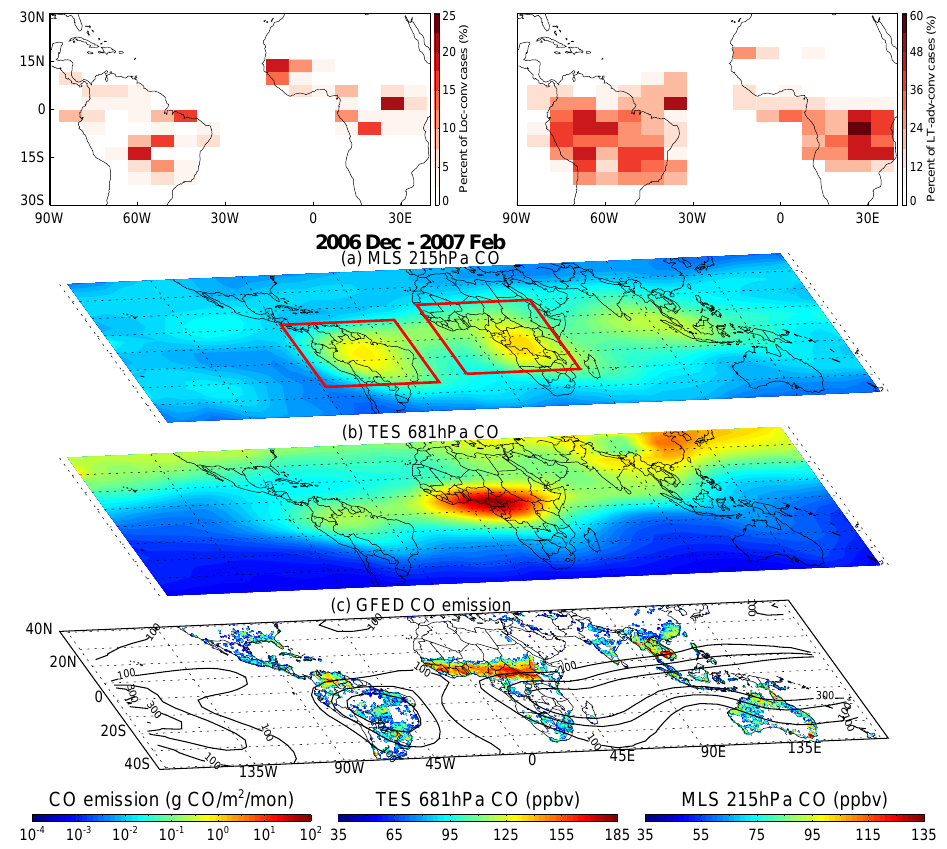
Fig. 4. Seasonal (December 2006–February 2007) mean distributions of (a) MLS CO in the upper troposphere (215hPa, scaled by 0.5), (b) TES CO in the lower troposphere (681hPa), and (c) GFED surface CO emission (color shading) and CloudSat CWC vertically integrated above 6km (contours). The CWC contour interval is 100mgm − 3 . The two selected analysis domains are outlined in red: South America (24 ◦ S–12 ◦ N, 88–32 ◦ W) and Central Africa (20 ◦ S–20 ◦ N, 16 ◦ W–40 ◦ E). The two panels at the top show the spatial distributions of the relative frequency (percentage) of each transport pathway for each 8 × 4 ◦ grid box in the two analysis domains: “local convection” (left), “LT advection → convection”